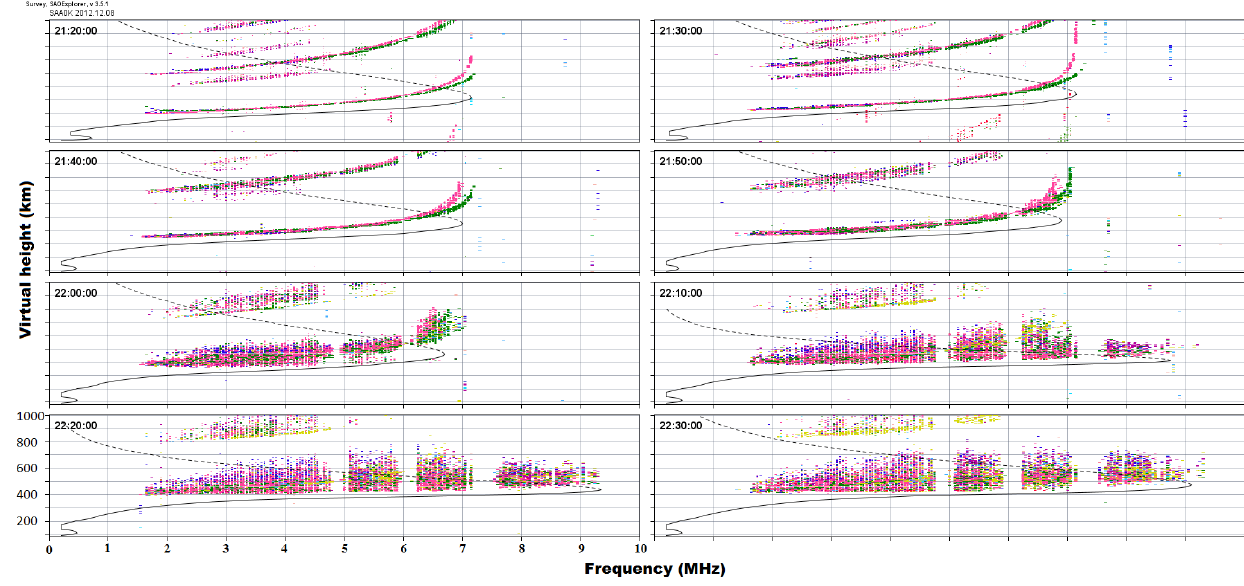
Figure 2. Sequence of ionograms taken on 8 December 2012 (18:20–19:30LT) at São Luís. Spread F begins around 19:00LT.